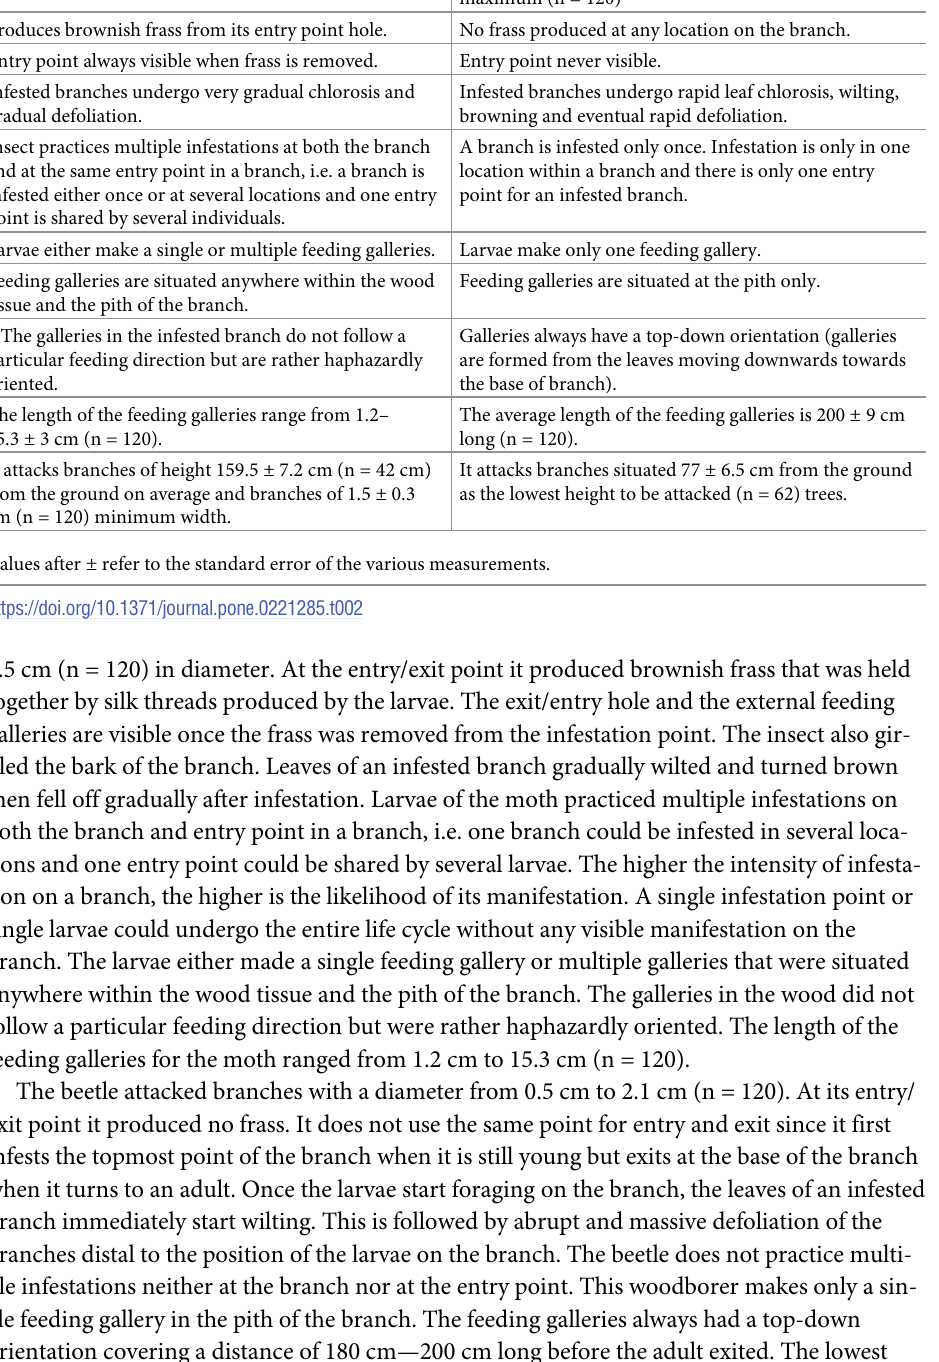
Table 2. Summary of the infestation manifestation strategies employed by the two insect woodborers to infest S . alba in Kenya. Moth (Lepidoptera: Cossoidea Beetle (Cerambycidae: Lamiinae) Attacks branches thicker than 1.5 cm (n =